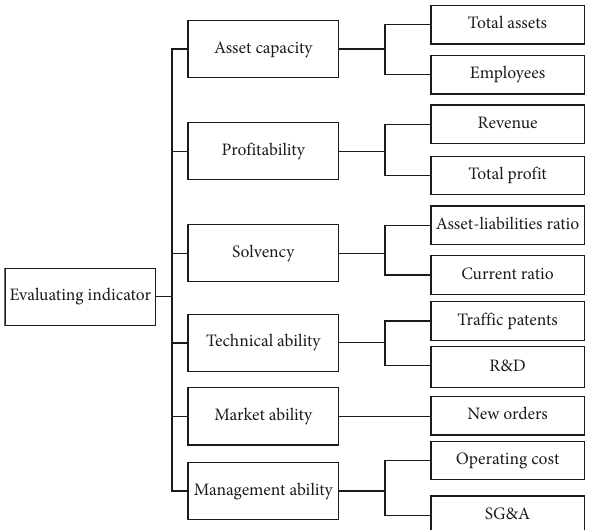
Figure 9: Evaluation system of rail equipment suppliers’